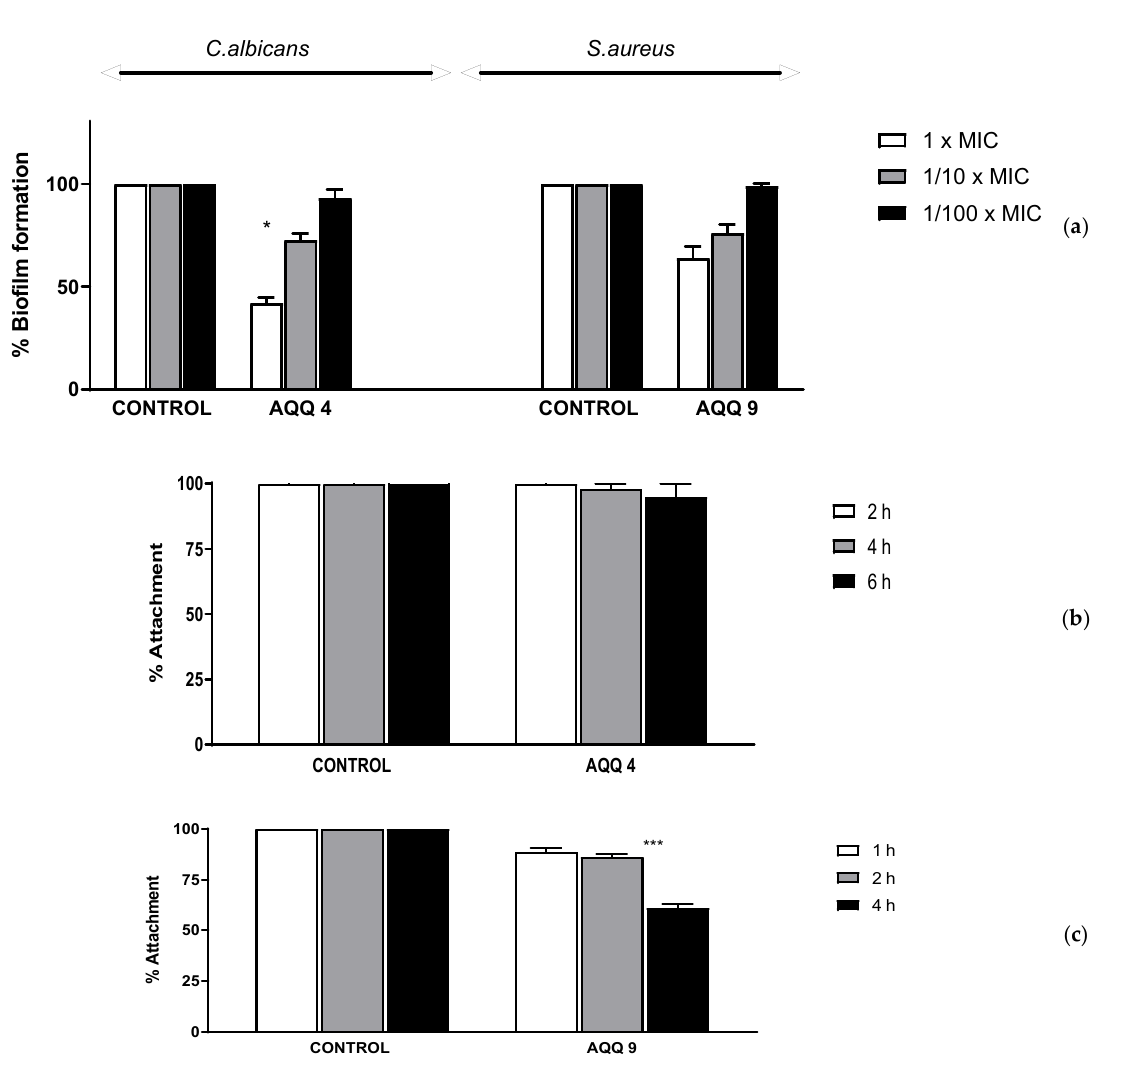
Figure 7. Inhibition of C. albicans and MRSA , respectively; ( a ) biofilm formation in each well contained 1 × , 1/10 × , or 1/100 × MIC of molecules and an inoculum of 1 × 10 6 –1 × 10 7 CFU/200 µ L, incubated for 24 h at 37 ◦ C for C. albicans and MRSA . ( b , c ) surface attachment to the wells contained 1/10 × MIC of molecules and an inoculum of 1 × 10 6 CFU/200 µ L, incubated for 2, 4, or 6 h at 37 ◦ C for C. albicans and incubated for 1, 2, or 4 h at 37 ◦ C for MRSA . Control bars indicate microorganisms without molecules accepted as 100%. Six wells were used for the tested molecules. Each experiment is representative of two independent tests. All differences between the control and molecules treated biofilms were statistically significant (* not significant, *** p <